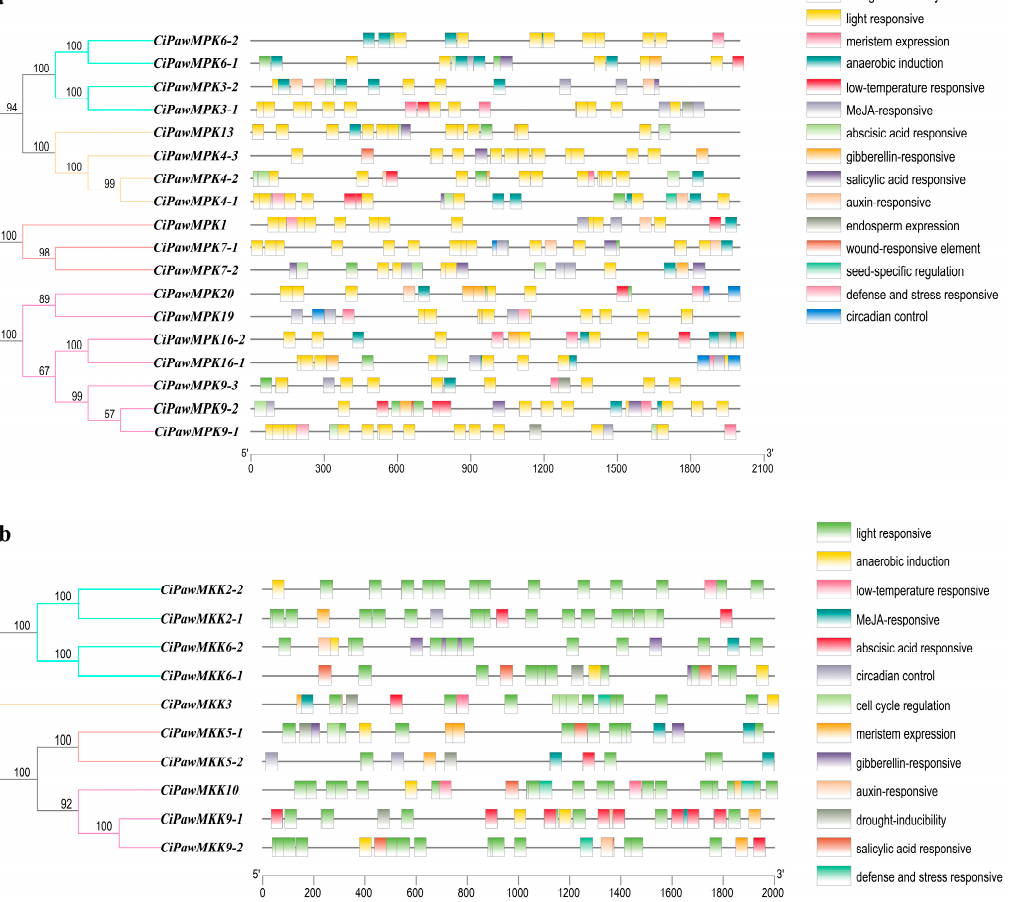
Figure 4. Cis-acting elements of MPK ( a ) and MKK ( b ) genes in pecan. Three types of cis-acting elements were found, including hormone-responsive elements, elements related to resistance to harsh environments and stress, and elements related to plant growth and development.